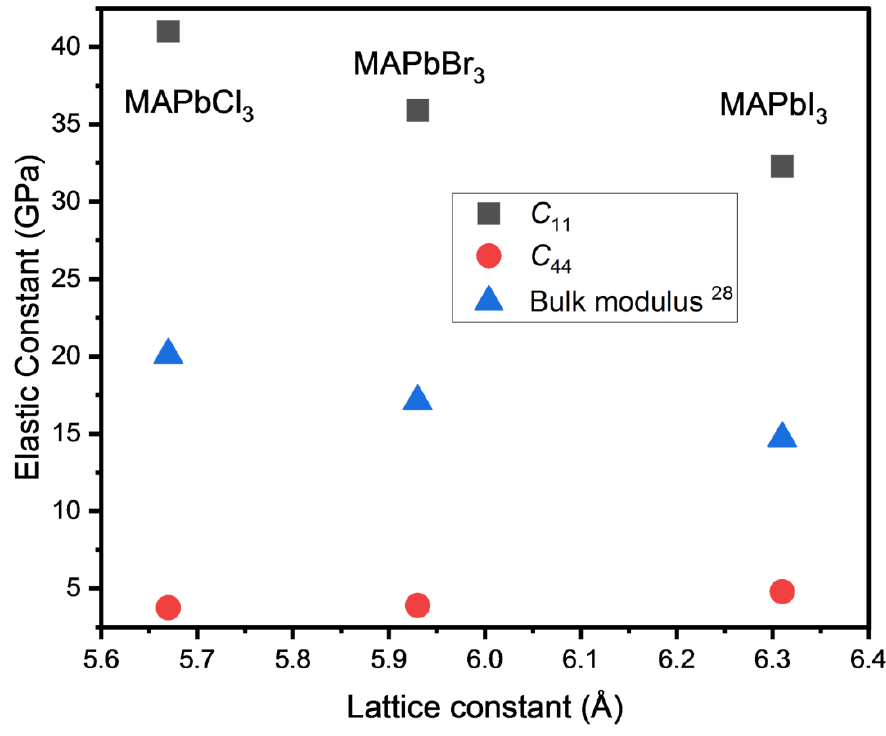
Figure 7. (Color online). Comparison of two elastic constants, C 11 and C 44 , and the bulk modulus of three MA-based halide perovskites at room temperature. The C 11 and C 44 of MAPbCl 3 are from the present work and other values are from several references, as shown in Table 1.